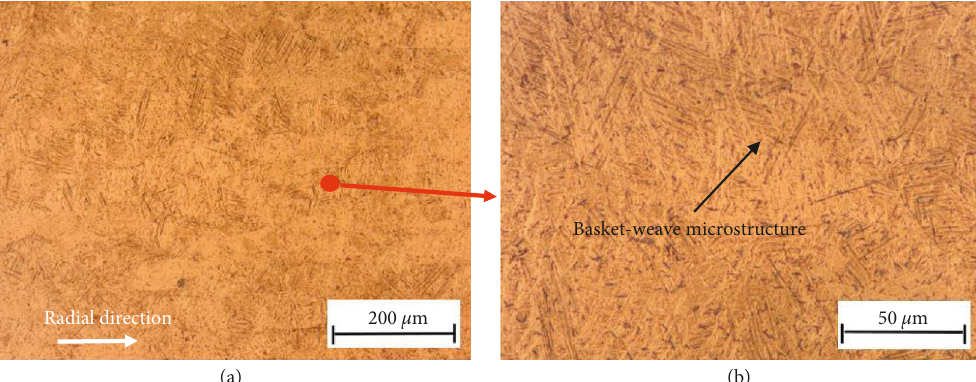
Figure 21: (a) Optical micrograph and (b) higher magnification optical micrograph, both showing the initial microstructure of a 10mm thick plate.